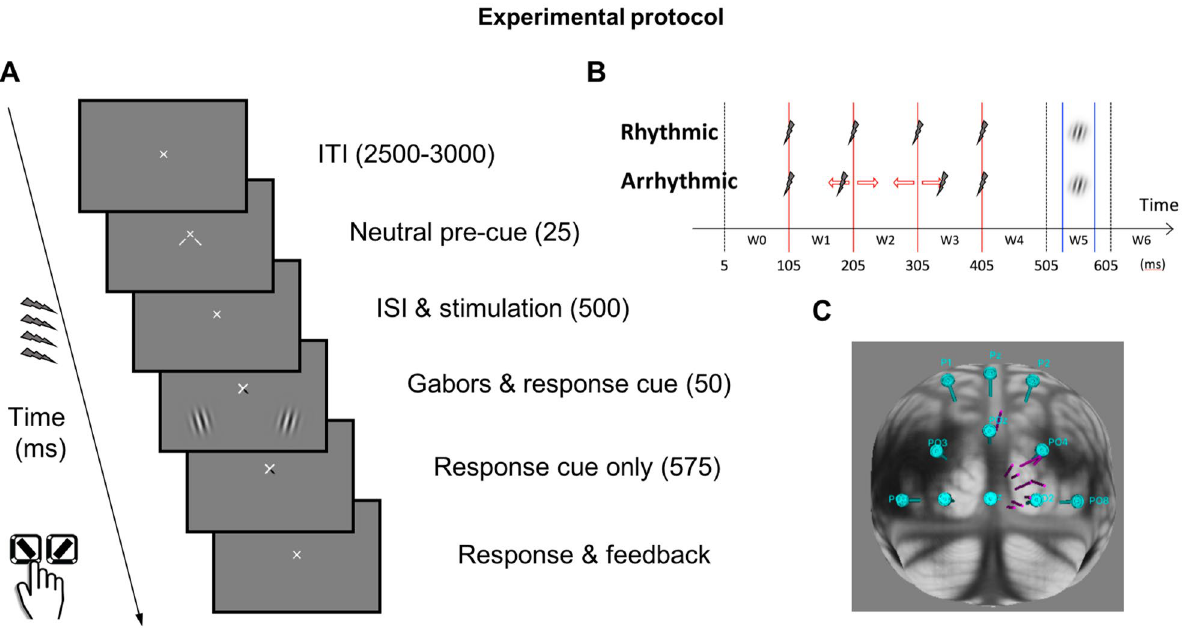
Figure 1. Experimental protocol ( A ) Trial structure. Each trial began with an intertrial period (ITI), followed by a neutral pre-cue to indicate the two stimulus locations. Active or sham stimulation was delivered in the interstimulus interval (ISI) between the neural pre-cue and the Gabor stimuli. The response cue indicated which Gabor was the target. Participants responded whether the target Gabor was tilted to the left or to the right with a key press. ( B ) Stimulation patterns and analysis time windows. The onset of the pre-cue is at t = 0. The four red lines mark the pulse timings in the rhythmic condition. The two blue lines mark the timings of Gabors onset and offset. In the rhythmic condition, the gap between pulses was exactly 100 ms. In the arrhythmic condition, the timing of the second and the third pulses was jittered (see text and Fig. S1 for the probability distribution). Time window W0 is the cycle before the first pulse. Time windows W1, W2, and W3 are the cycles between pulse pairs. Time windows W4 and W5 are the first and the second cycles after the last pulse, respectively. ( C ) TMS loci and directions. Each cylinder represents the TMS directional vector of one participant on the MNI brain template. The cyan discs indicate the EEG electrode